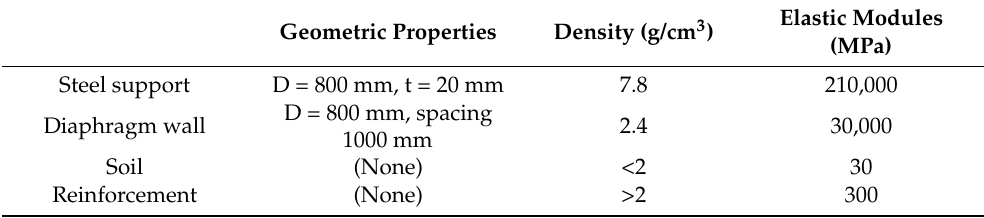
Table 3. Support structure parameters.